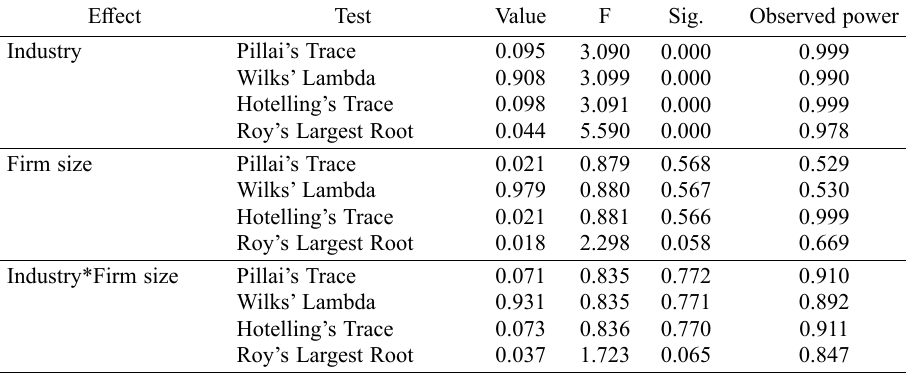
Table 4. Multivariate tests